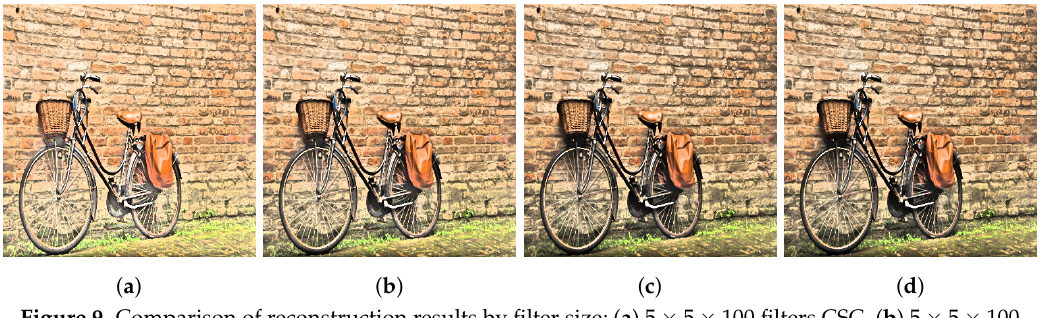
Figure 9. Comparison of reconstruction results by filter size; ( a ) 5 × 5 × 100 filters CSC, ( b ) 5 × 5 × 100 filters SVD-CSC, ( c ) 15 × 15 × 100 filters CSC, ( d ) 15 × 15 × 100 filters SVD-CSC.